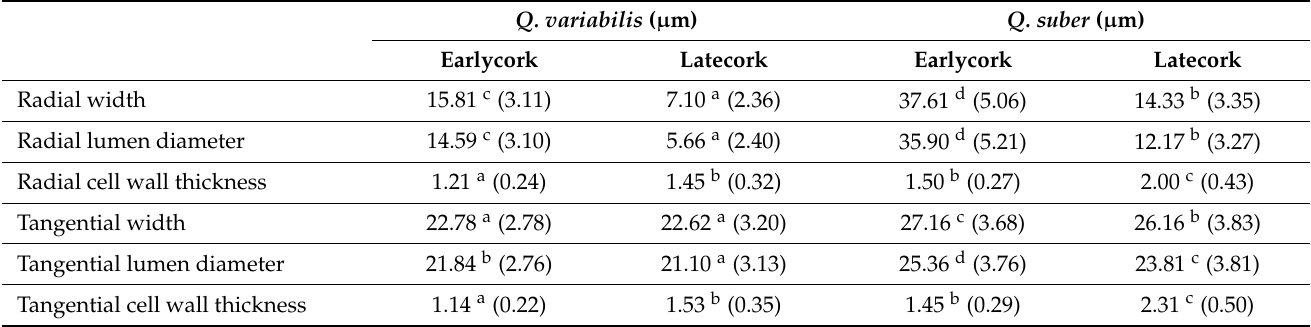
Table 6. Two-dimensional characteristics of the cork cells in Q. variabilis virgin cork and Q. suber reproduction